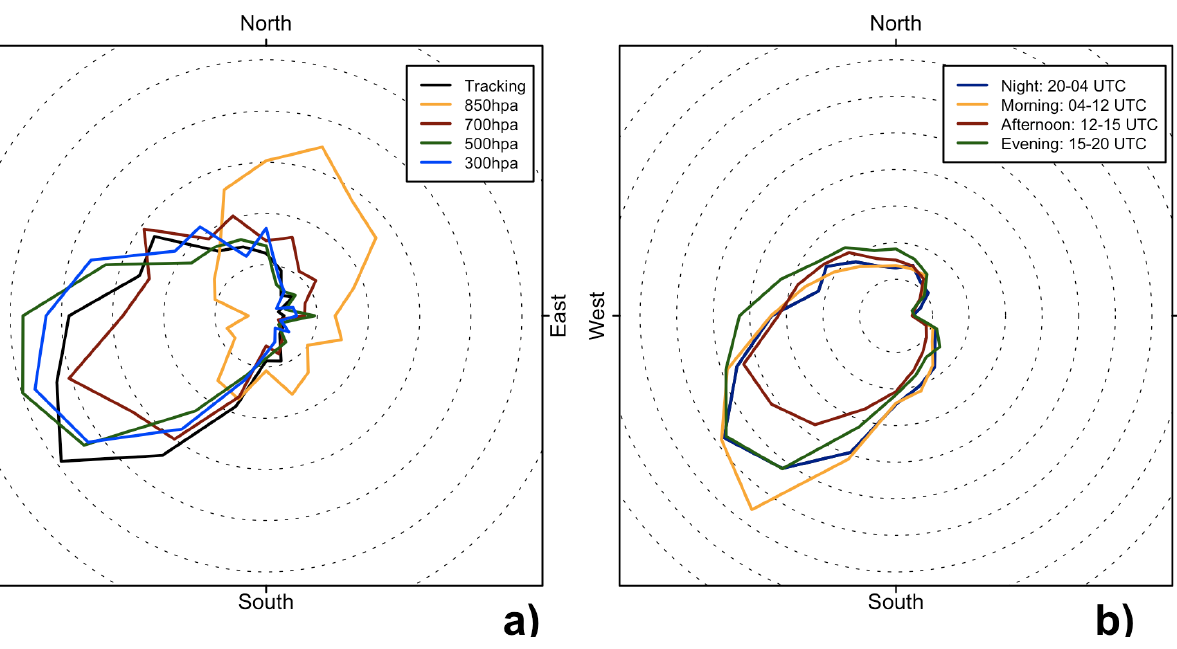
Figure 12. ( a ) Frequency distribution of the direction of daily provenance of storms (in black) and of winds at different levels (in grey tones). The direction classes have been evaluated every 20°. Circles are drawn every 20 days; ( b ) Same as ( a ), but for the direction of provenance of storms in the different hours of the days. Circles are drawn every 100 storms.